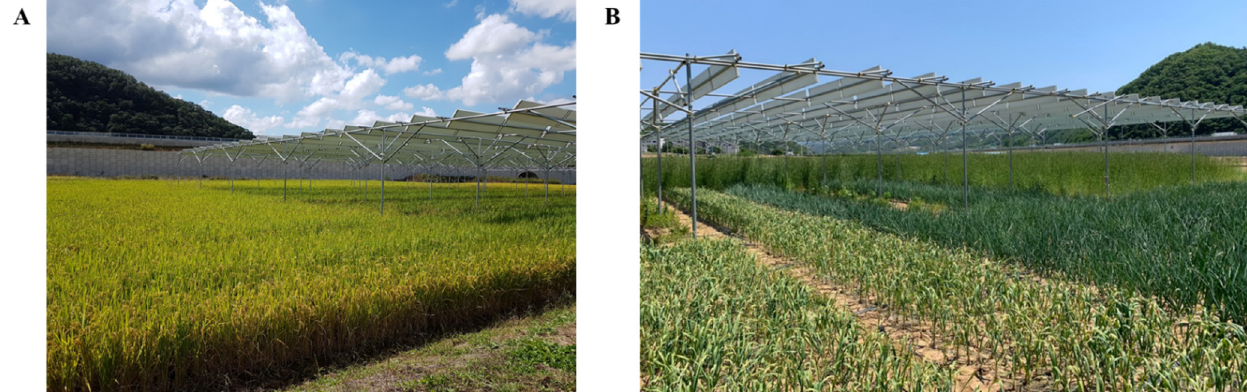
Figure 2. Crop production of the agro-photovoltaic system and open field at the experimental farm field. ( A ) Rice cultivation on the paddy field. ( B ) Onion and garlic cultivation on the dry field.